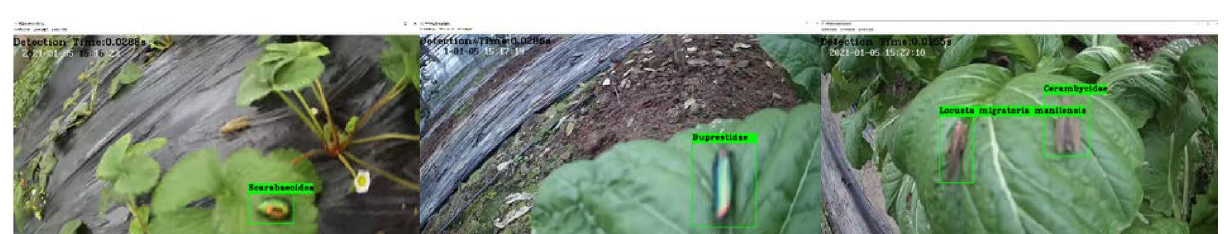
Figure 19. Test results in the greenhouse. Note : The first two pictures were a single-insect test result ( Scarabaeoidea or Buprestidae ) and the last picture was a multi-insect test result ( Locusta migratoria manilensis and Cerambycidae